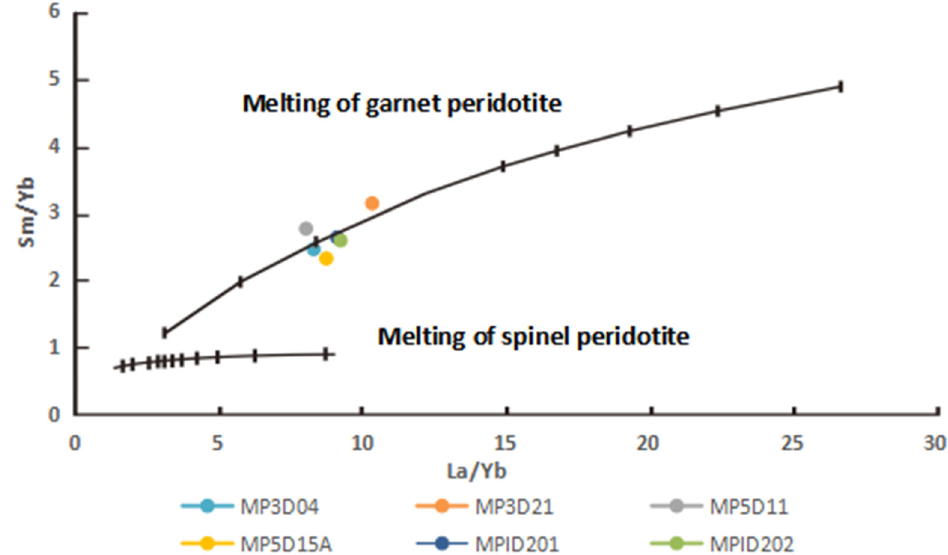
Figure 10. La/Yb–Sm/Yb diagram of seamount basalt in the Western Pacific (after Xu, Y. G. et al., 2005 [42]).